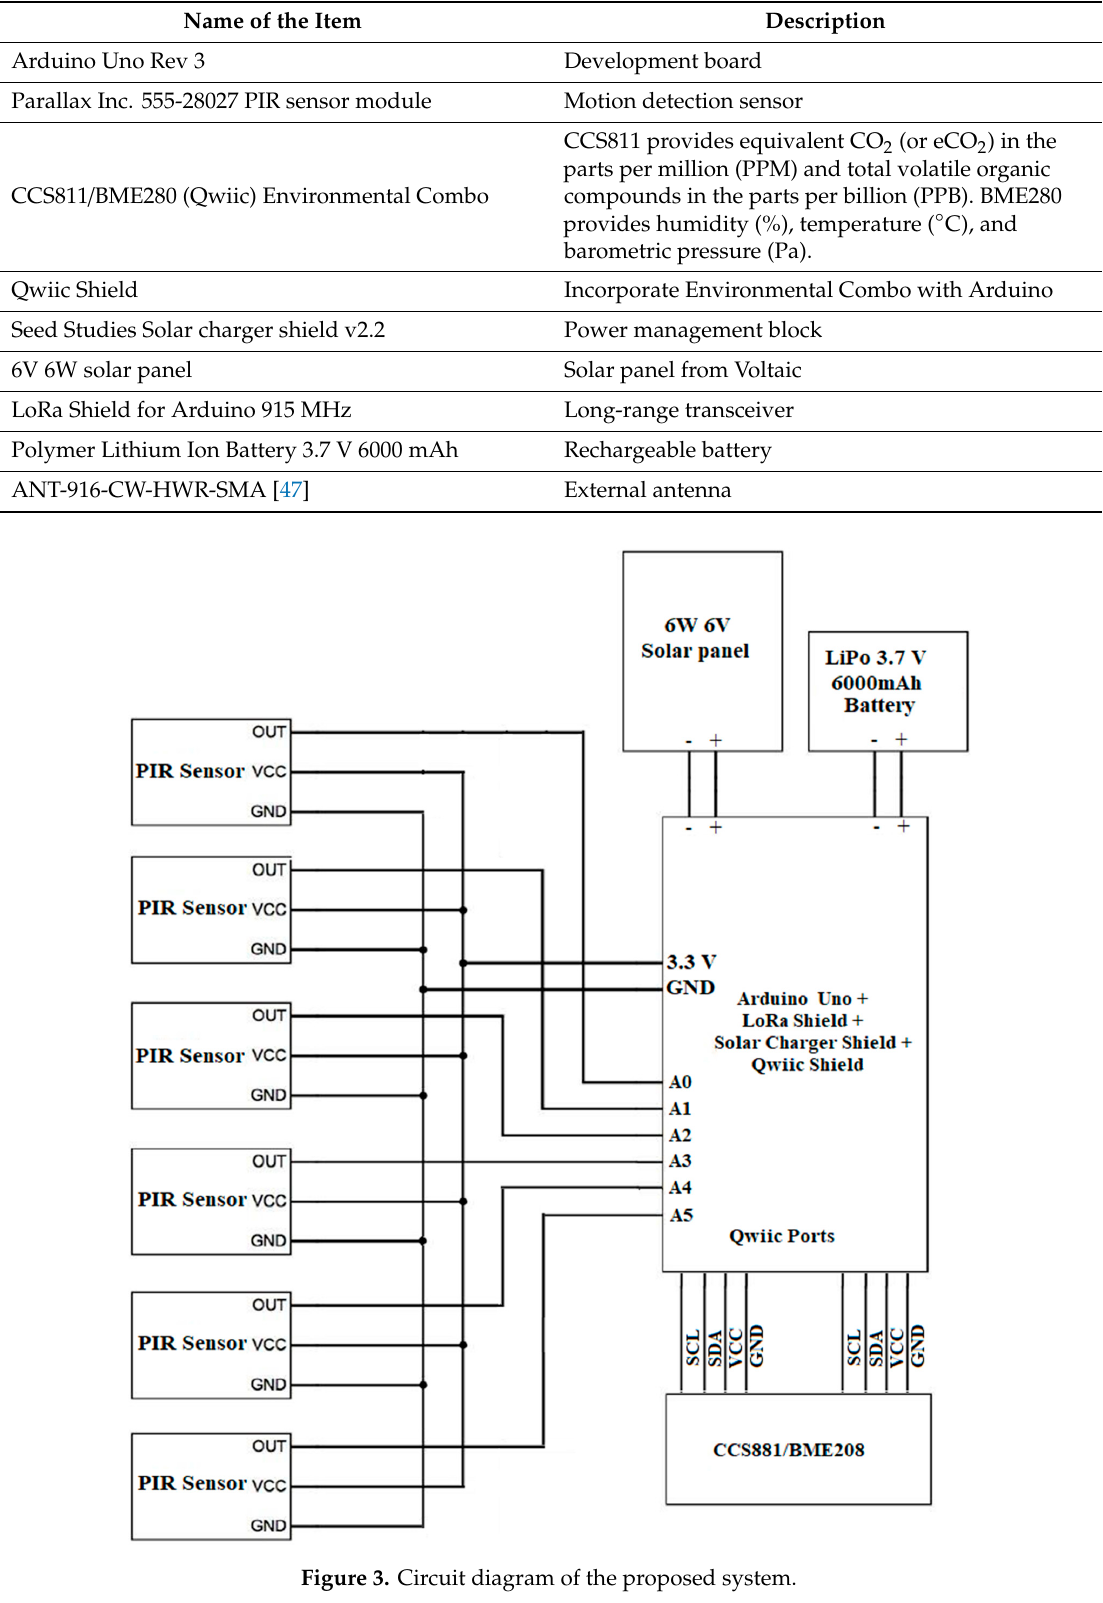
Table 3. Summary of the electronics used in the proposed system.